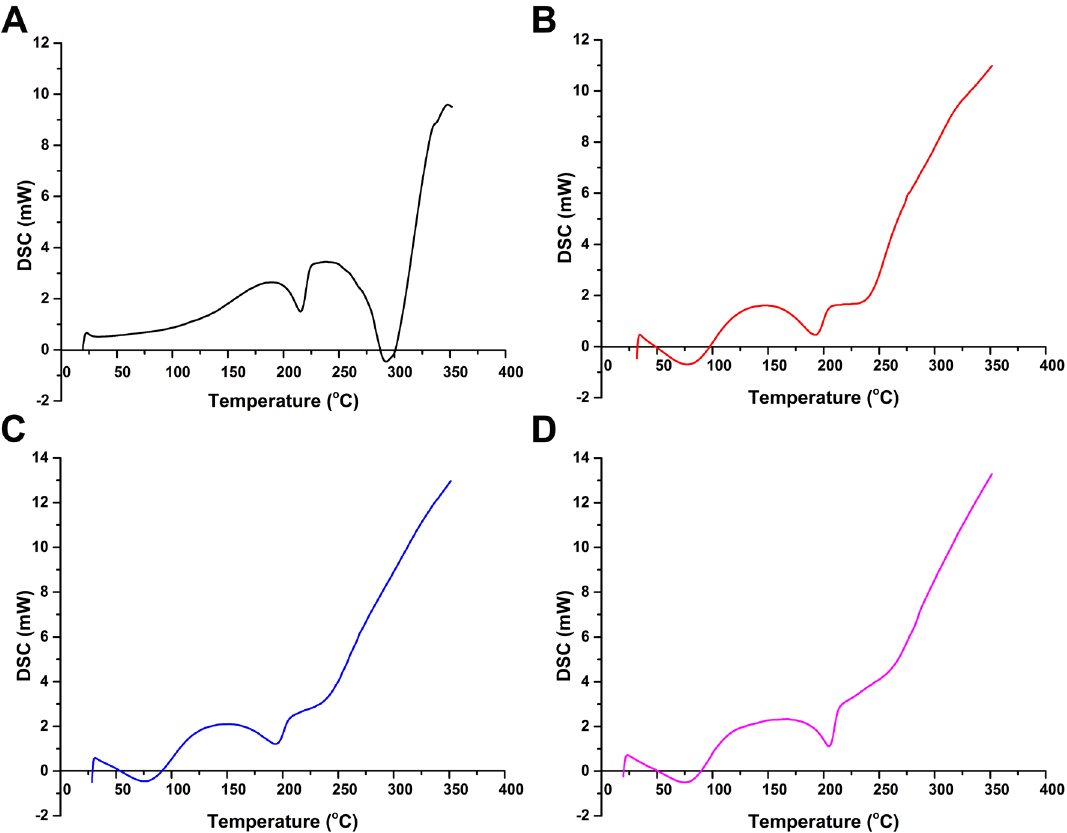
Figure 3. DSC analyses of ( A ) PVA hydrogel membrane, ( B ) PVA-K0.1, ( C ) PVA-K0.25, and ( D ) PVA-K0.5 composite hydrogel